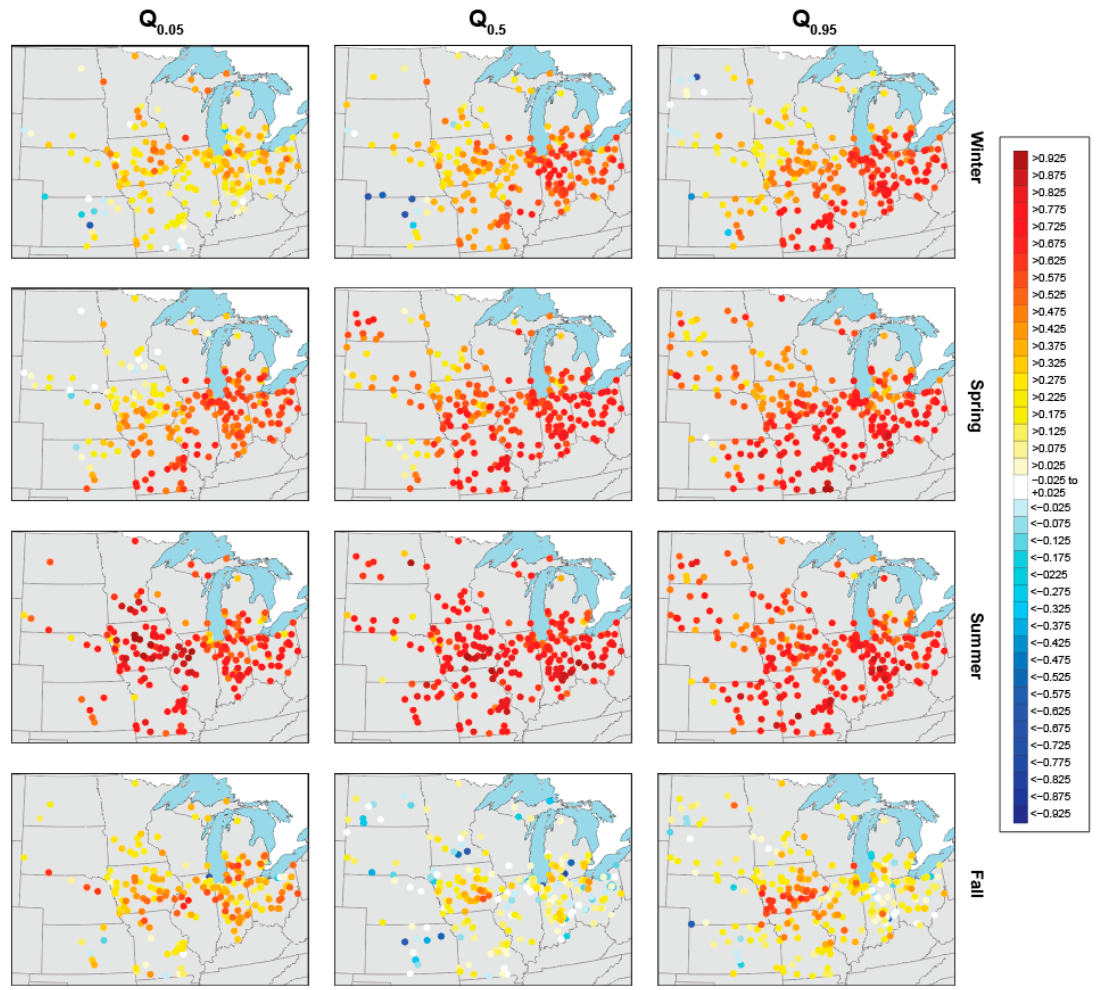
Figure 8. Correlation coefficient for the best-fitting model at each site based on cross-validation, shown by flow quantile and season. The symbology is the same as in Figure 7, to facilitate the comparison between the model fit and the cross-validation. Cross-validation is shown for all quantiles in Figure S5. For comparison, Figure S7 shows the same information as Figure 8 but computed with Spearman’s rho instead of Pearson’s R (nonparametric equivalent).